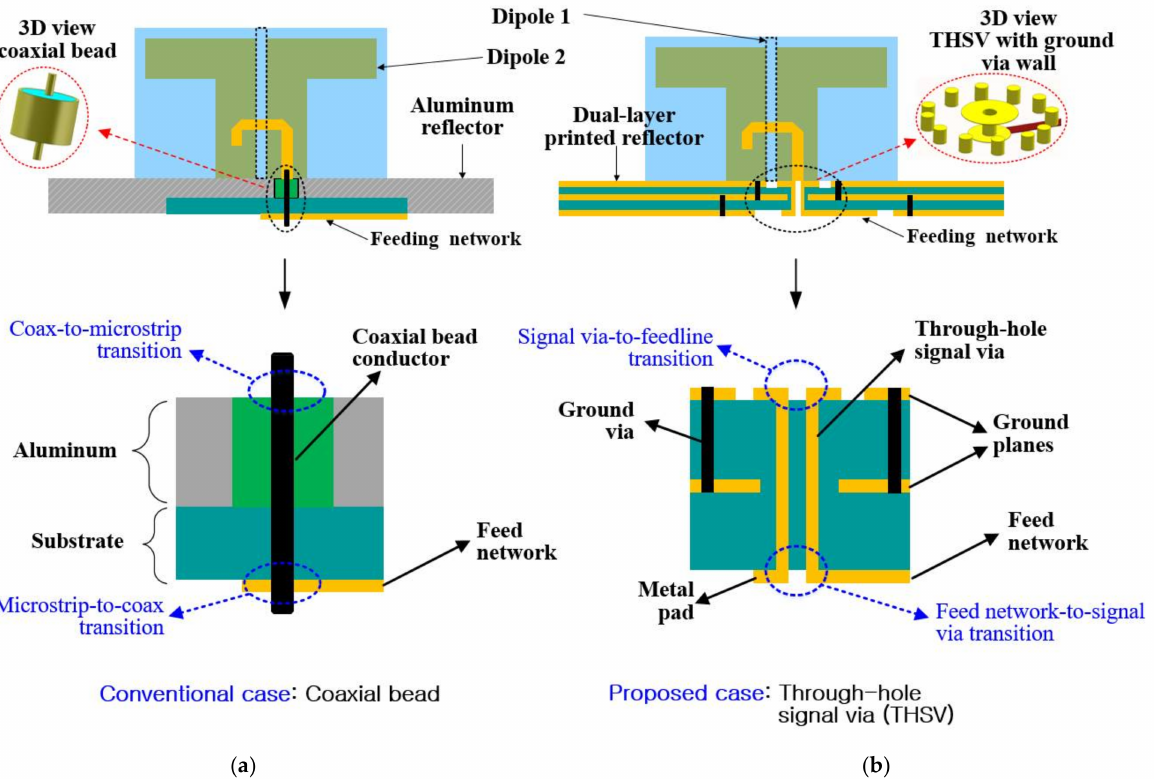
Figure 5. The feeding scheme of the printed cross dipole antenna showing: ( a ) Coaxial bead interconnection; ( b ) Proposed through-hole signal via (THSV)